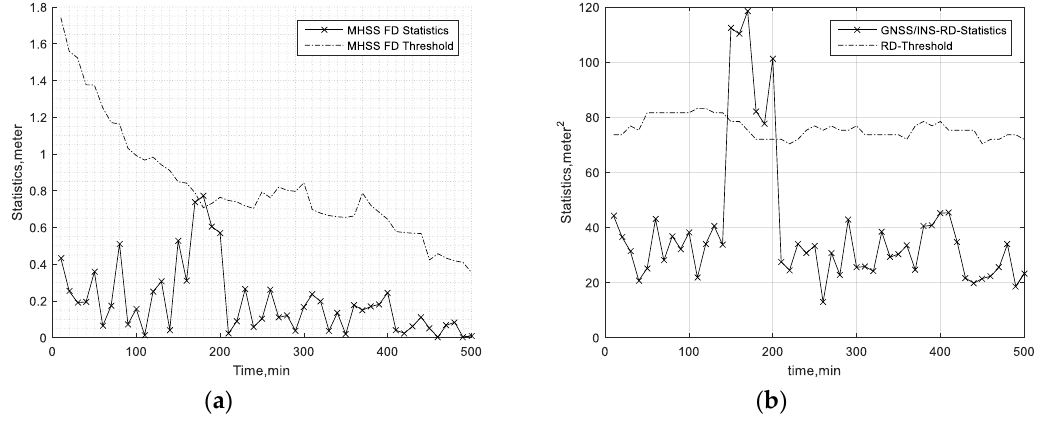
Figure 3. FD test in the second case. ( a ) MHSS FD test. ( b ) RD FD test.